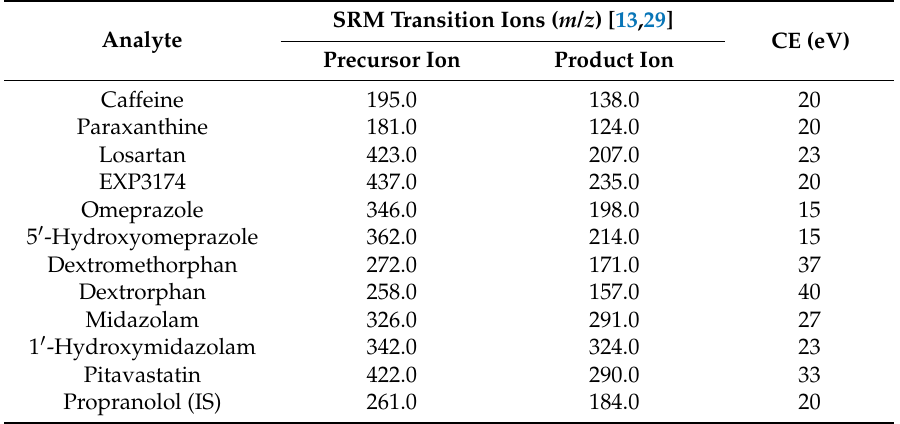
Table 2. Selected reaction monitoring (SRM) transition ion and collision energy (CE) values for the analysis of analytes and internal standard